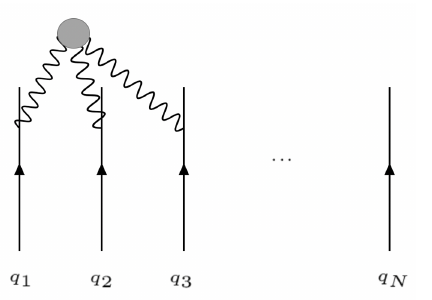
Figure 2. Typical three-quark interaction, beyond